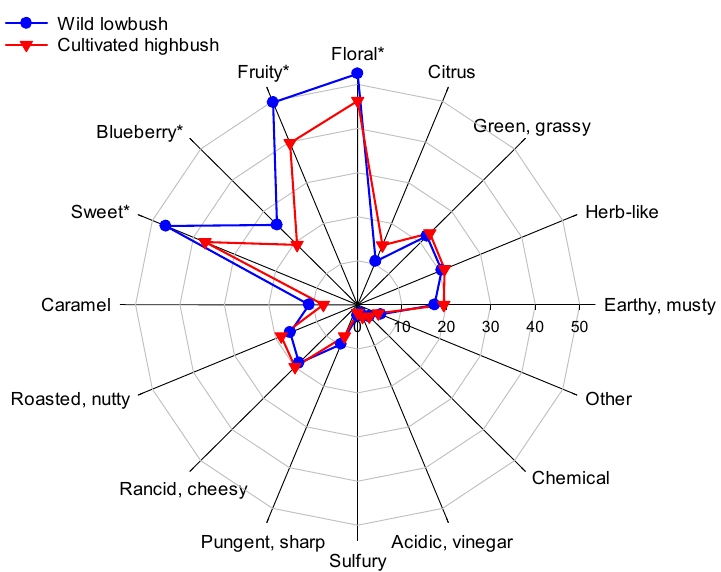
Figure 3. Frequency of descriptors chosen by sensory panelists to describe aroma-active compounds from wild lowbush and cultivated highbush blueberry fruit samples analyzed by gas chromatography-olfactometry (GC-O). Values represent the mean frequencies of descriptors chosen by five evaluators. Significant differences determined by LSD 0.05 are indicated by “*” next to the descriptor. GC-O analysis was conducted on fruit collected from three wild lowbush blueberry fields located in four provinces (n = 12), and from five cultivars of cultivated highbush blueberries from three fields (n = 15).